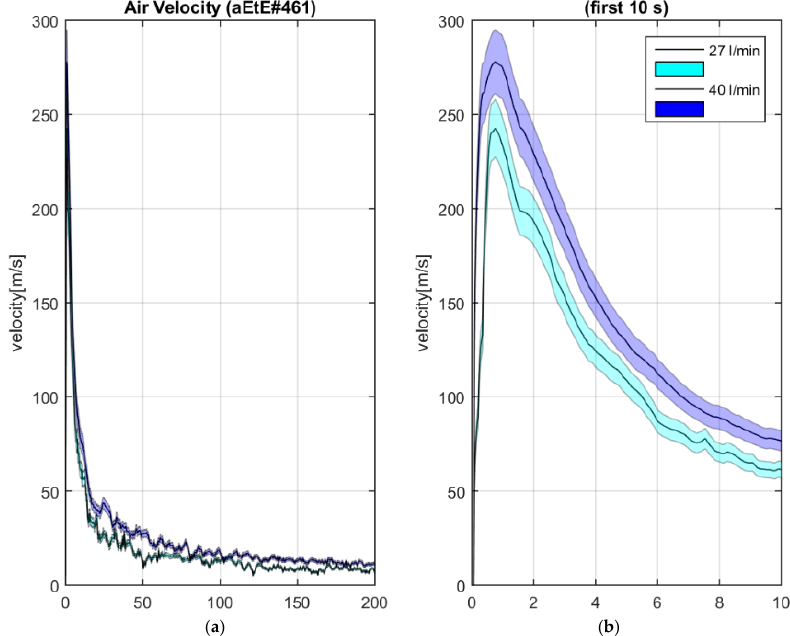
Figure 15 . ( a ) Description of the velocities variation during the whole experiments. ( b ) A detail of the velocities variation in the first 10 s.